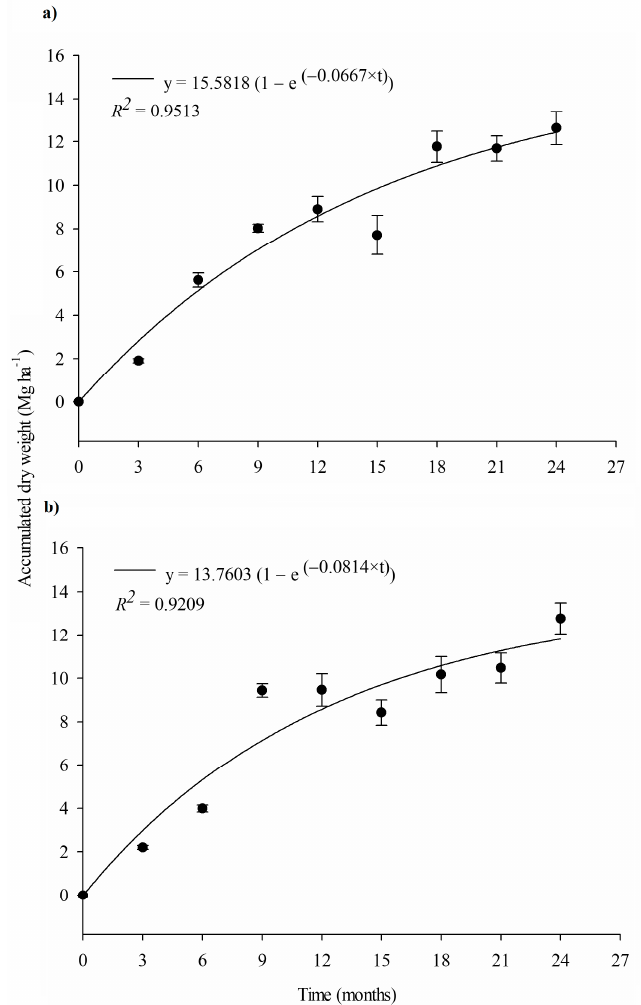
Figure 6. Adjusted models for litter accumulation of E. grandis ( a ) and P. taeda ( b ). The vertical bars indicate the standard error of the mean ( n = 3).